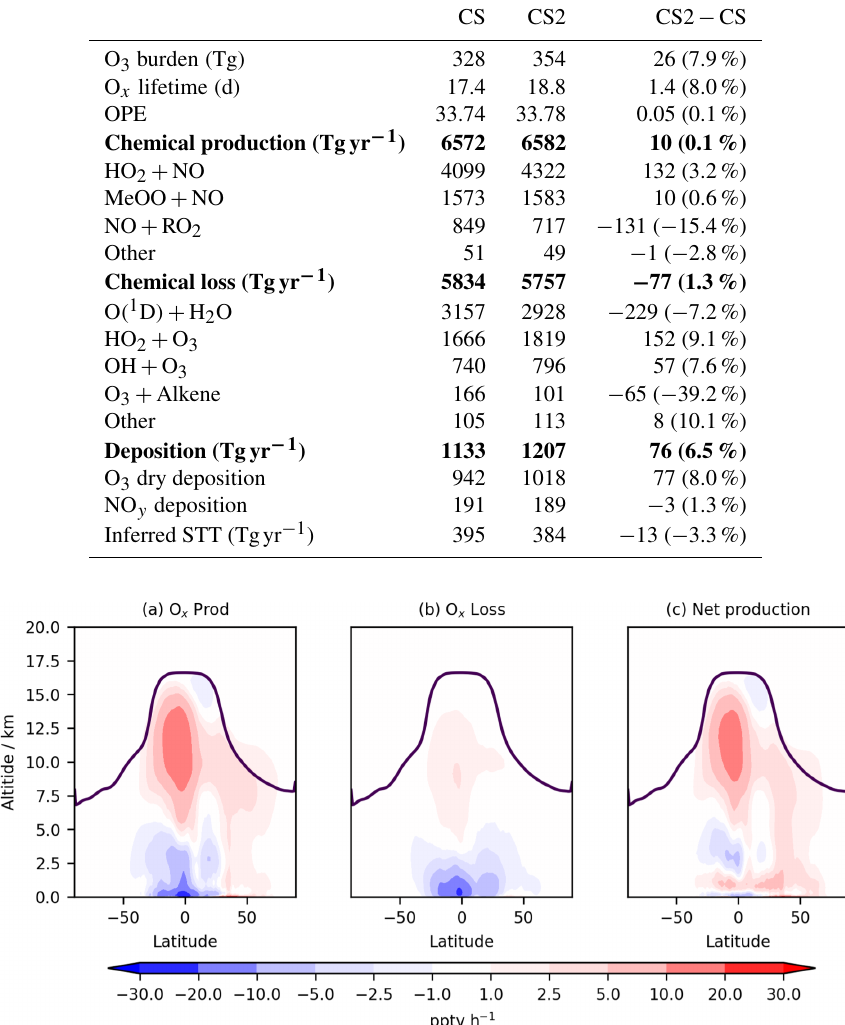
Figure 5. Annual zonal mean change in (a) total O x production flux, (b) total O x chemical loss flux, and (c) net O x chemical production flux. The purple line indicates mean tropopause